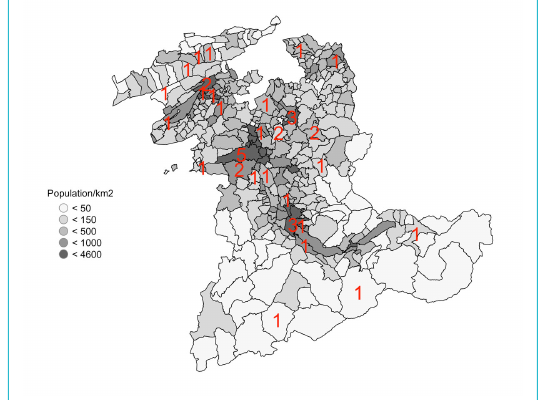
Figure 1b: Communities of the Canton of Bern and their popula- tions per km 2 (grey), with the number of patients with Behçet’s syn- drome per community in red.